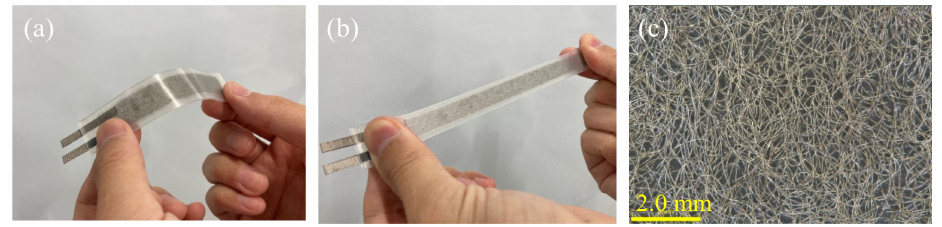
Figure 3. Appearances of the fabricated sensor (( a ): non-stretched, ( b ): stretched) and a micrograph of the silver-plated fiber flocked in the conductive layer ( c